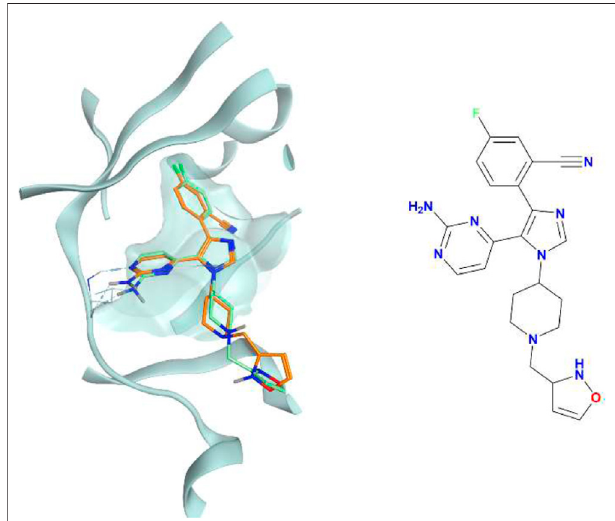
FIGURE 11 | The superposition between the docking-predicted binding mode of a high-scoring compound (MMS2) from the benchmark lead- optimization run performed with the IFP CS scoring protocol and the reference crystal binding pose of compound PFO from the structure deposited in the Protein Data Bank with accession code 4TN6. On the left part of the image, the protein kinase CK1 δ ATP binding site is reported in teal ribbon, the pose of the compound MMS2 is shown as orange sticks, while the pose of compound PFO is shown as green sticks. On the right part of the image, the chemical structure of the compound MMS2 is